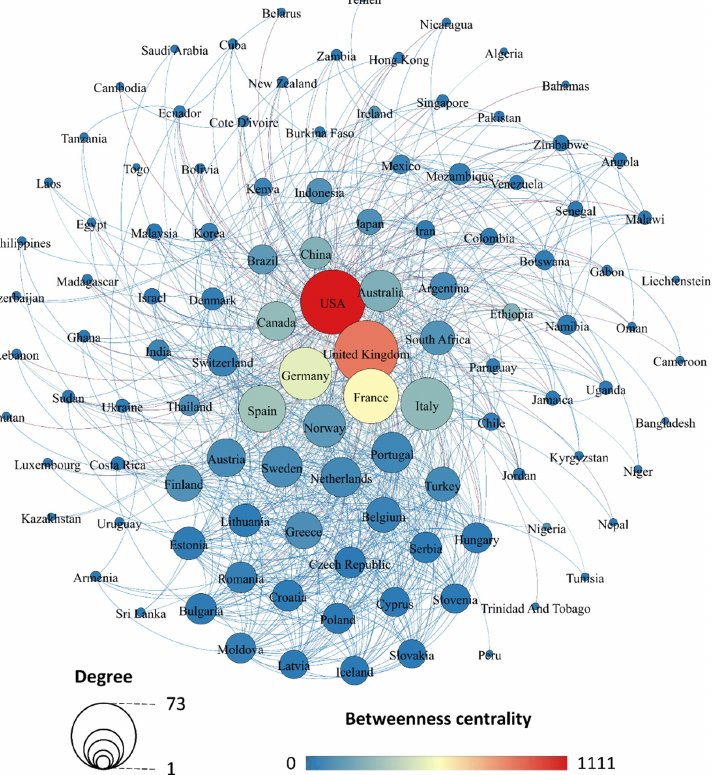
Figure 9. Collaboration network in fire-management research between countries according to Scopus (1973–2021).